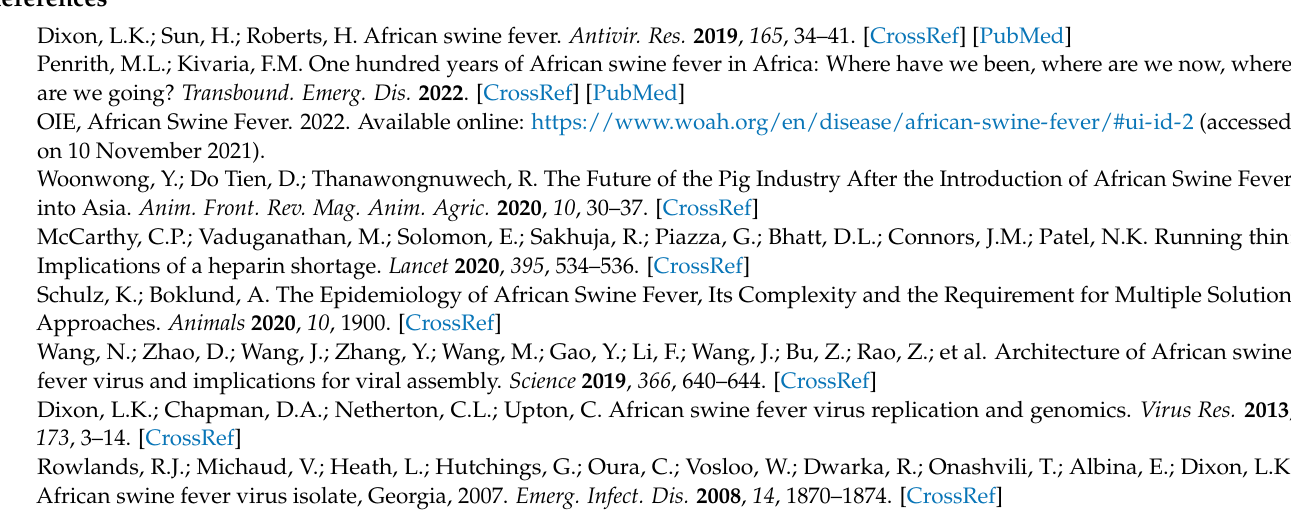
Table S3: A curated dataset of ASFV genome sequences. Table S4: The length of genome, coding region sequence (CRS) and conserved central region (CCR) of the ASFV genome sequences in the curated dataset. References [45–65] are cited in the supplementary